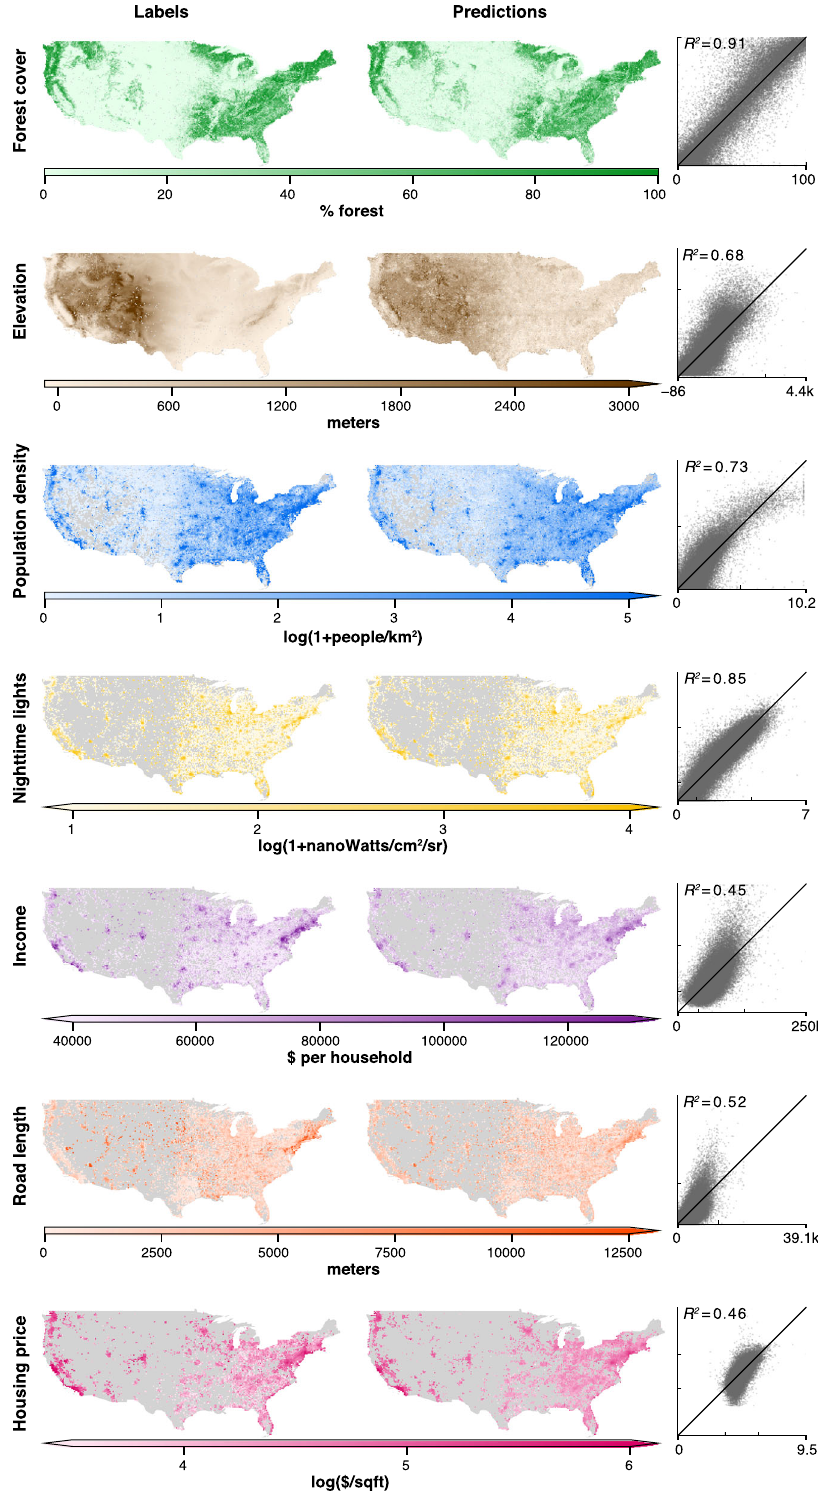
Fig. 2 1 km × 1 km resolution prediction of many tasks across the continental US using daytime images processed once, before tasks were chosen. 100,000 daytime images were each converted to 8,192 features and stored. Seven tasks were then selected based on coverage and diversity. Predictions were generated for each task using the same procedure. Left maps: 80,000 observations used for training and validation, aggregated up to 20 km × 20 km cells for display. Right maps: concatenated validation set estimates from 5-fold cross-validation for the same 80,000 grid cells (observations are never used to generate their own prediction), identically aggregated for display. Scatters: Validation set estimates (vertical axis) vs. ground truth (horizontal axis); each point is a ~1 km × 1 km grid cell. Black line is at 45 ∘ . Test-set and validation set performance are essentially identical (Supplementary Table 2); validation set values are shown for display purposes only, as there are more observations. The tasks in the top three rows are uniformly sampled across space, the tasks in the bottom four rows are sampled using population weights (Supplementary Note 2.1); grey areas were not sampled in the